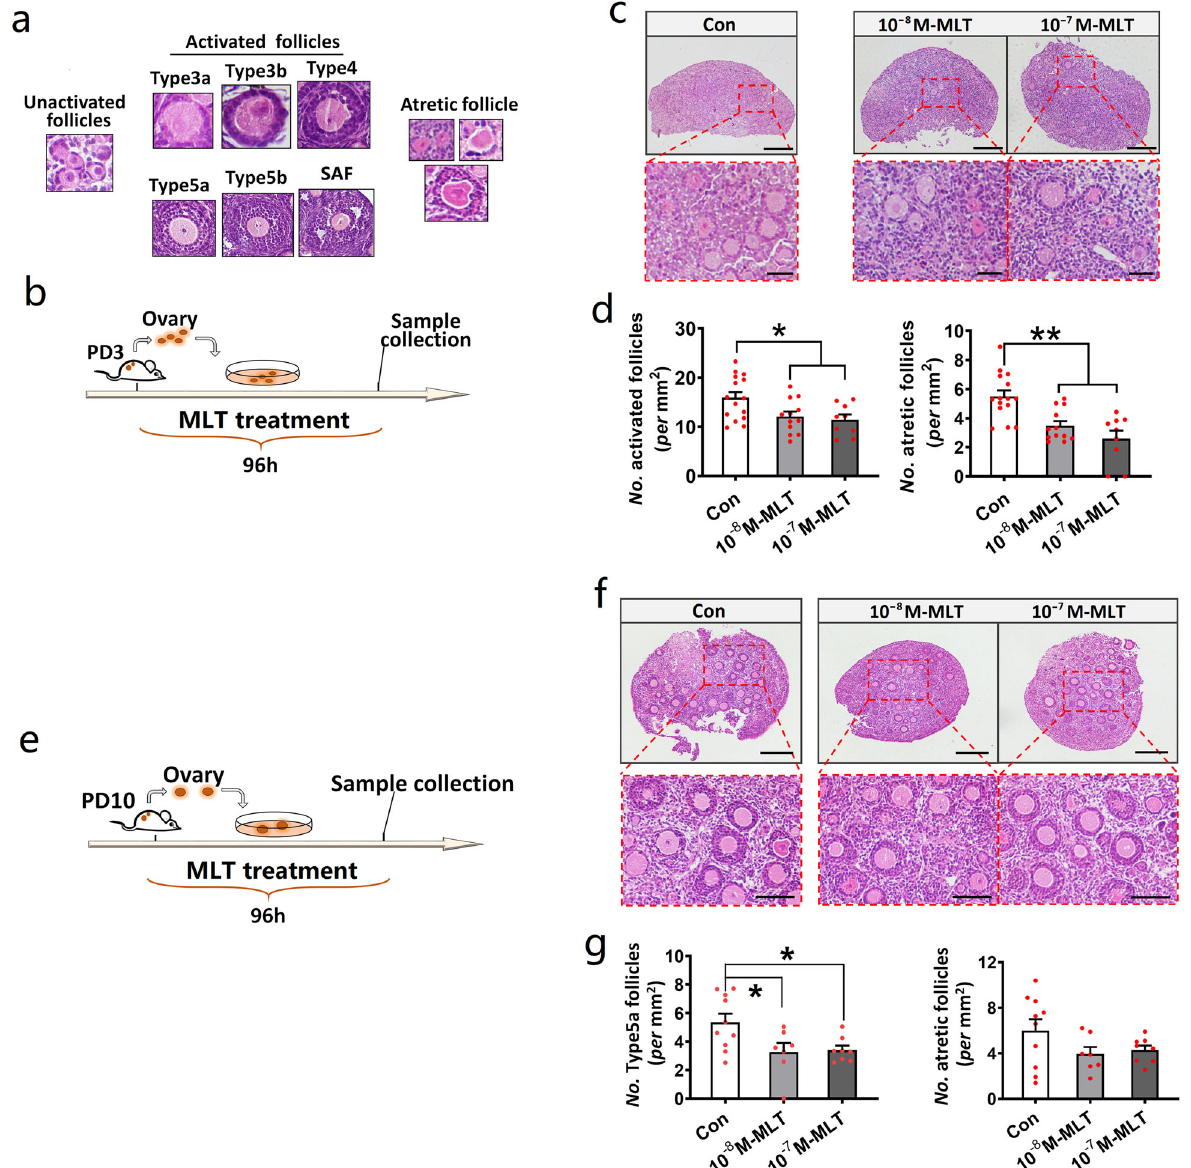
Fig. 2 MLT addition inhibited early folliculogenesis in in vitro ovary culture system. a Identi fi cation standards of the activated and atretic follicles. b – d The effect of MLT addition on follicle activation and atresia. n = 5 (Con), 4 (10 − 8 M MLT), and 3 (10 − 7 M MLT) biologically independent ovaries, respectively. b Experimental design. c Representative photographs of H&E staining in each group. The scale bars are 100 µ m in the original images and 20 µ m in the enlarged images. d The statistical charts of activated and atretic follicles (values are mean ± SEM). The number of sections used for